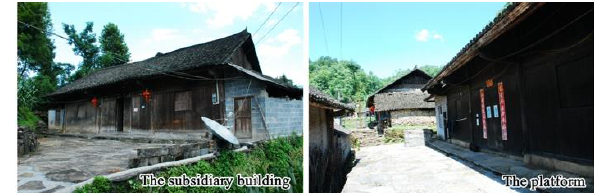
Figure 4. The subsidiary building and the courtyard.